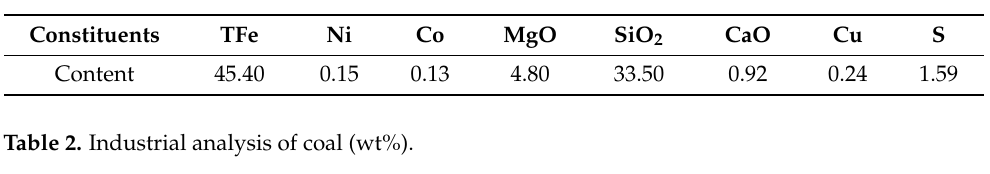
Table 1. Chemical composition of ferronickel slag (wt%).